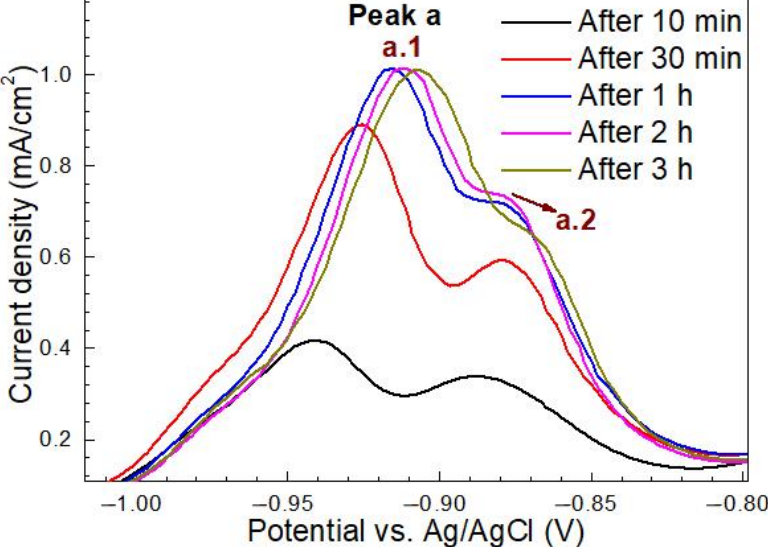
Figure 8. The first cyclic voltammetry (CV) scans for the base metal after hydrogen charging for 10 min, 30 min, 1 h, 2 h, and 3 h in NaOH solution containing thiourea (scan rate 10 mV/s).